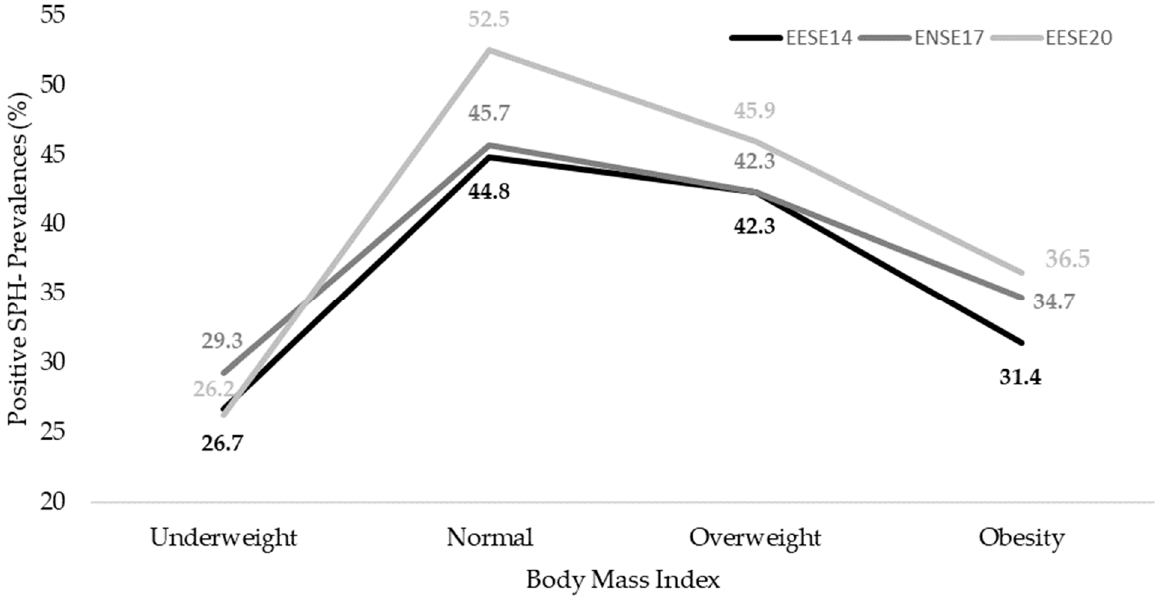
Figure 3. Positive Self-Perceived Health (SPH) prevalence according to the Body Mass Index (BMI) in the Spanish population in the three surveys EESE2014, ENSE2017, and EESE2020.